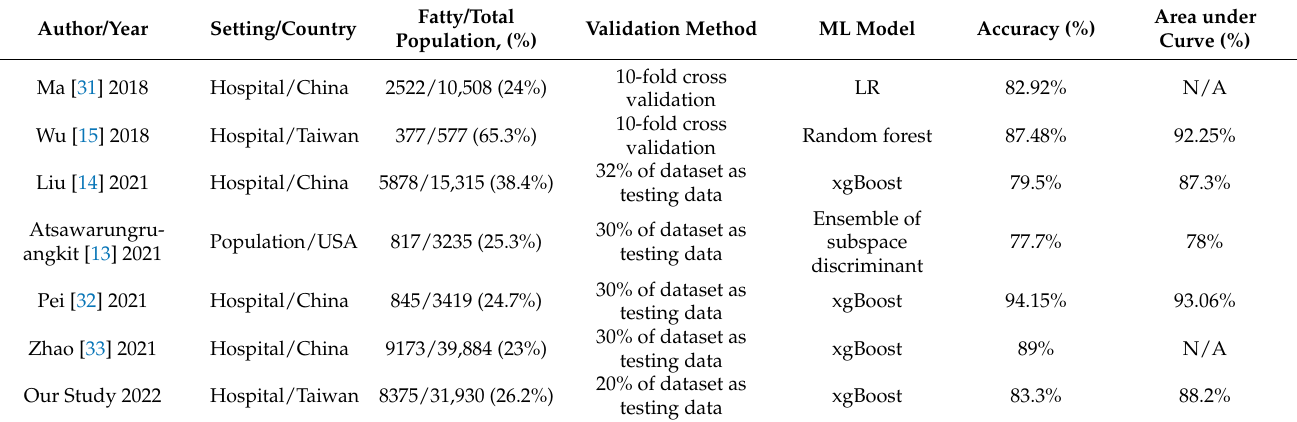
Table 5. Literature review of previous studies of machine learning for fatty liver